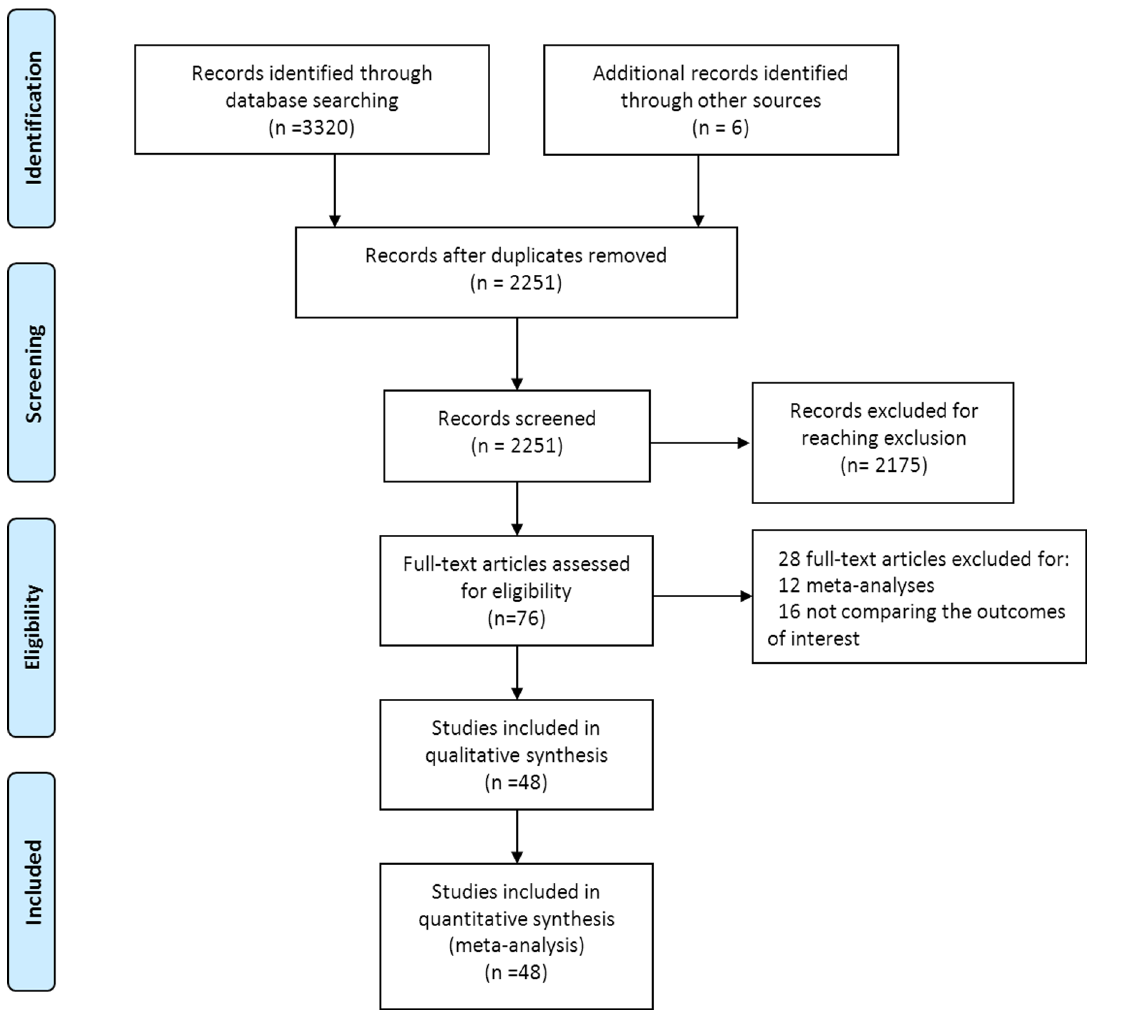
Fig 1. Flow Diagram of the search and selection